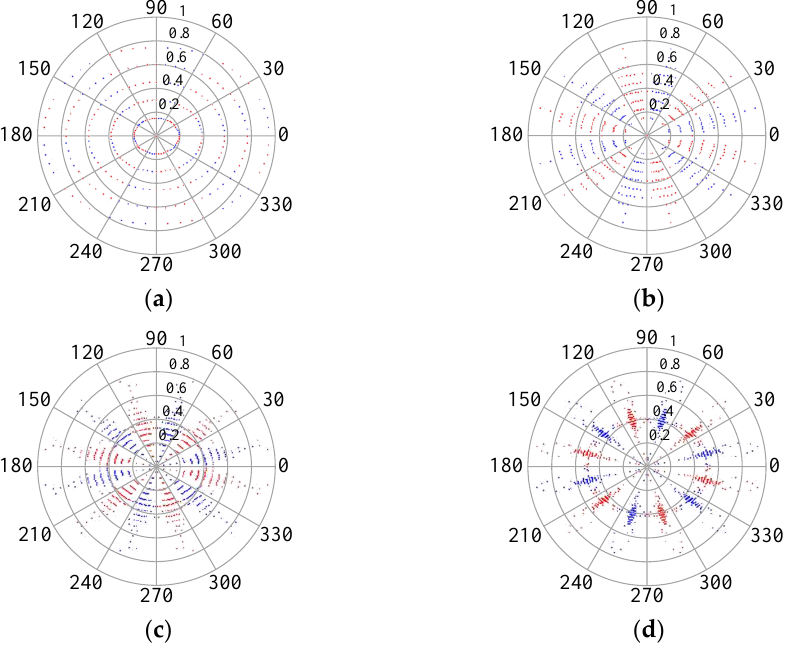
Figure 12. SDP feature images of power cable defect fault types. ( a ) Normal power cable; ( b ) power cable outer semi-conducting layer defect; ( c ) power cable insulation with impurities; ( d ) power cable insulation damage defect. Table 1. Hyperparameters in CNN training